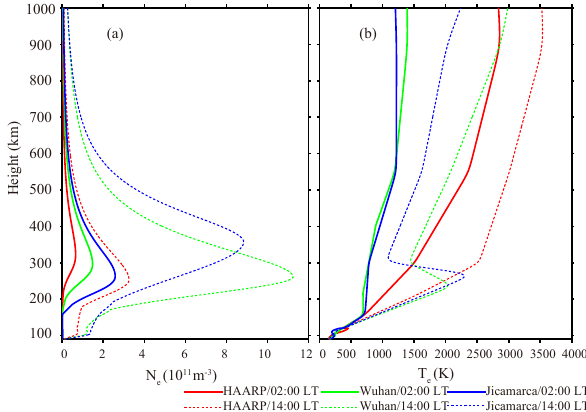
Figure 1. The background ionospheric electron density and temper- ature profile used in our numerical